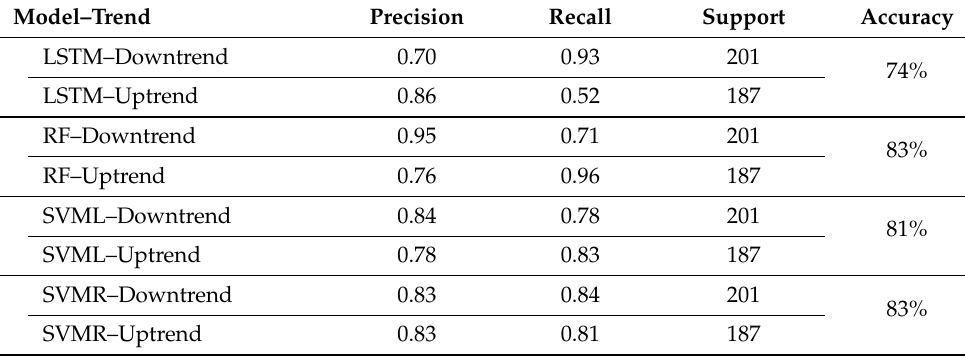
Table 4. Hit ratios of predictions to 126-days